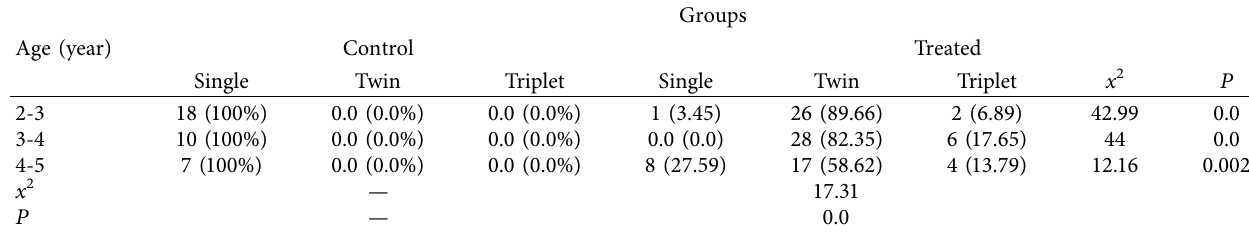
Table 3: Te percentages of lambs born according to the type of birth related to the age of Awassi ewes impregnated with intravaginal progestin sponges along with eCG and the control group.